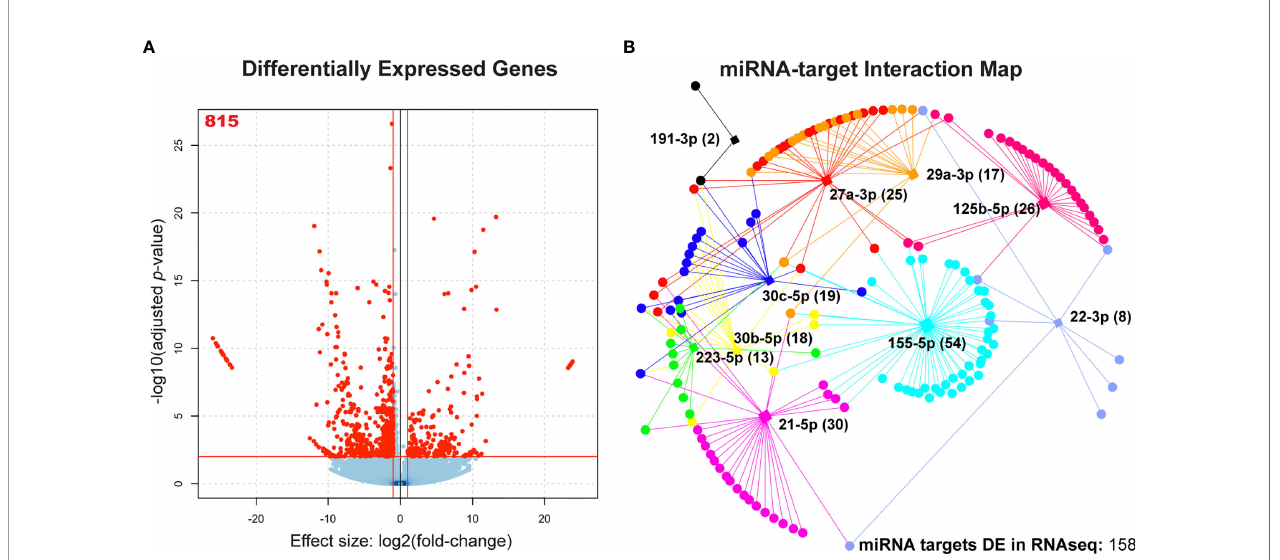
FIGURE 3 | Association of signi fi cantly dysregulated miRNAs with differentially expressed cognate mRNAs during Mtb infection of human MDMs. (A) Volcano plot showing all differentially expressed mRNAs during Mtb infection. n = 4 independent human donors. Red lines represent signi fi cance thresholds, red number represent total number of signi fi cantly DE mRNAs. (B) Interaction map showing network of candidate miRNAs and their respective targets. Square nodes represent each candidate miRNA (labeled). Circular nodes and points represent differentially expressed gene targets (targets identi fi ed by miRTarBase v8.0 and miRNet). Numbers in parentheses beside each miRNA label represent the number of gene targets that are also signi fi cantly dysregulated in the RNAseq results. Each miRNA node is uniquely color-coded. Edges that extend between miRNA nodes and gene and gene target nodes are coded to the same color of their respective miRNA